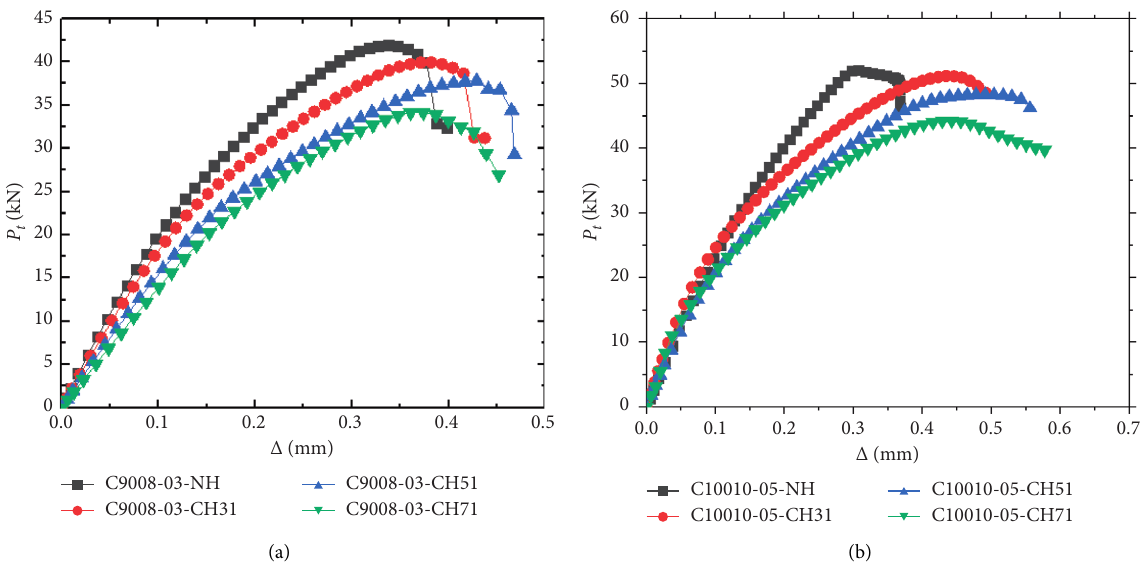
Figure 15: Comparison of load and axial displacement curves for section C9008 series. (a) Section C9008 series. (b) Section C10010